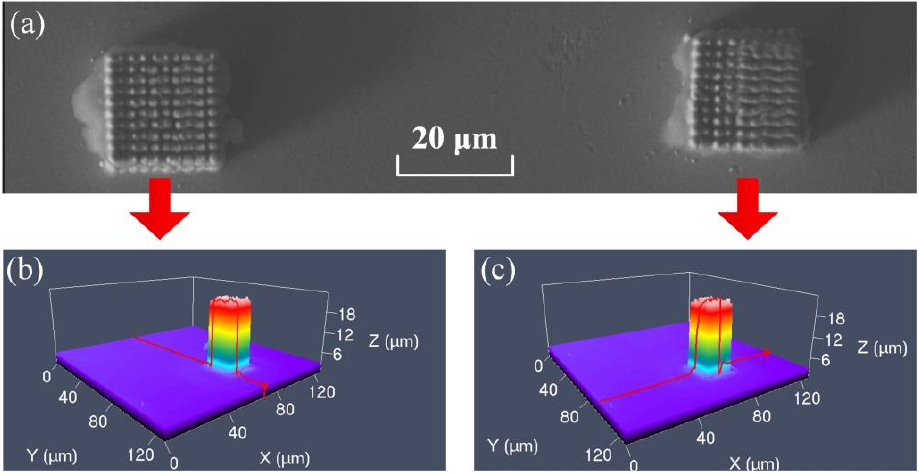
Figure 3. The two cubes were fabricated near each other. ( a ) The cube with a square surface and each boundary is 20 μm in length. ( b ) and ( c ) The dimension is measured by laser scanning confocal microscope for the first and second cube.